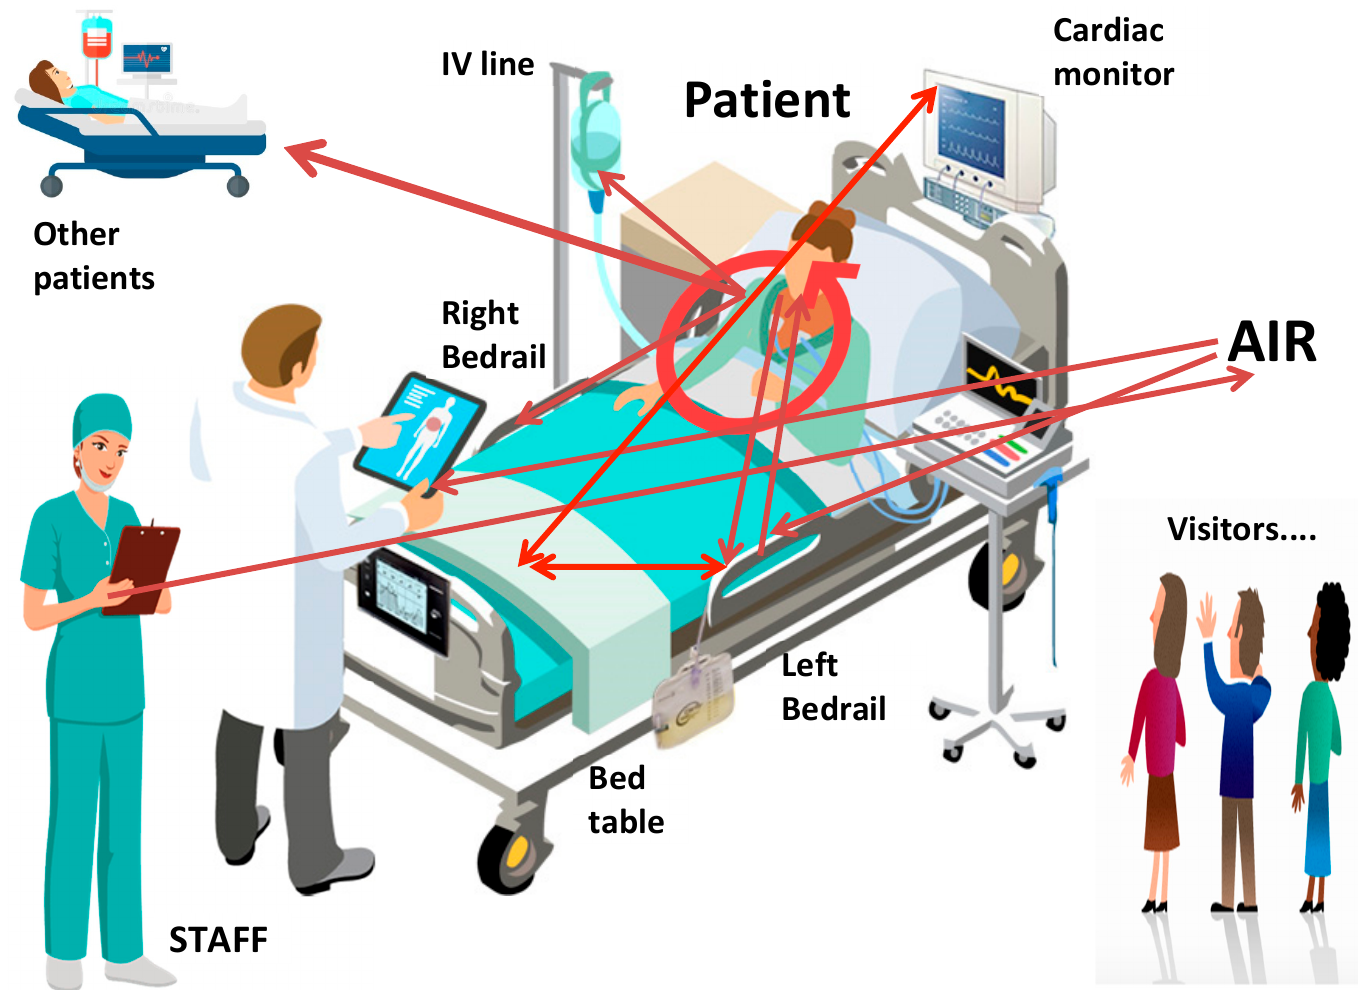
Figure 5. Transmission pathways of S. aureus on one ICU. ICU: intensive care unit; MSSA: methicillin-susceptible S. aureus ; MRSA: methicillin-resistant S. aureus